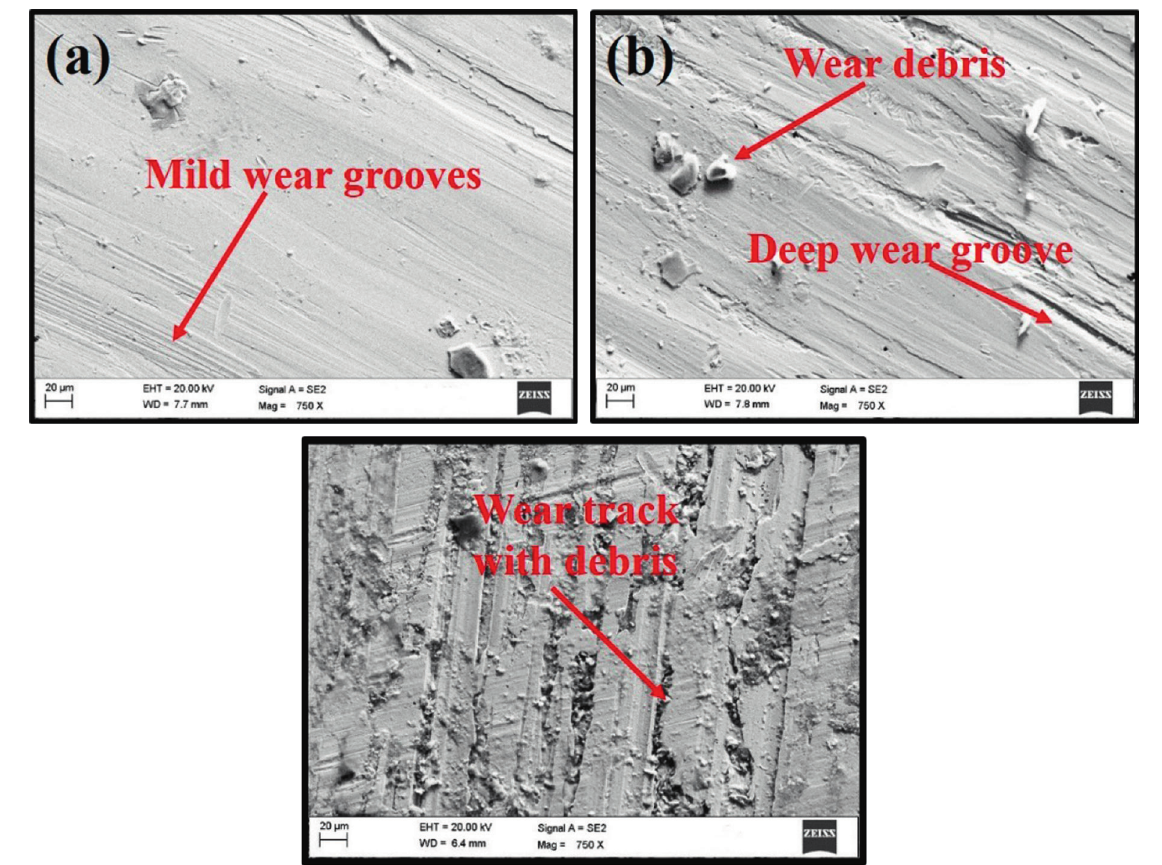
Figure 18: FESEM micrograph of worn surface of CuNi/B (c) 1400rpm.